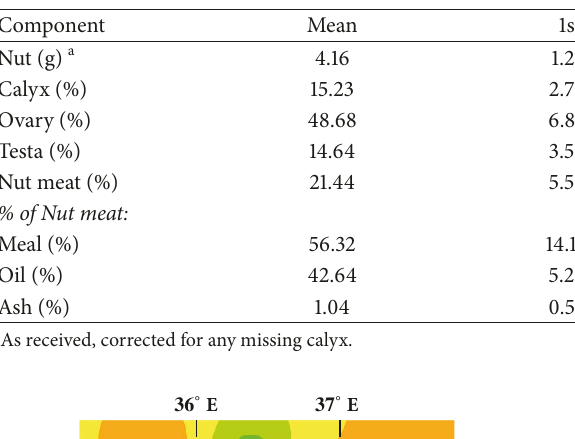
Table 1: Composition of the nuts.